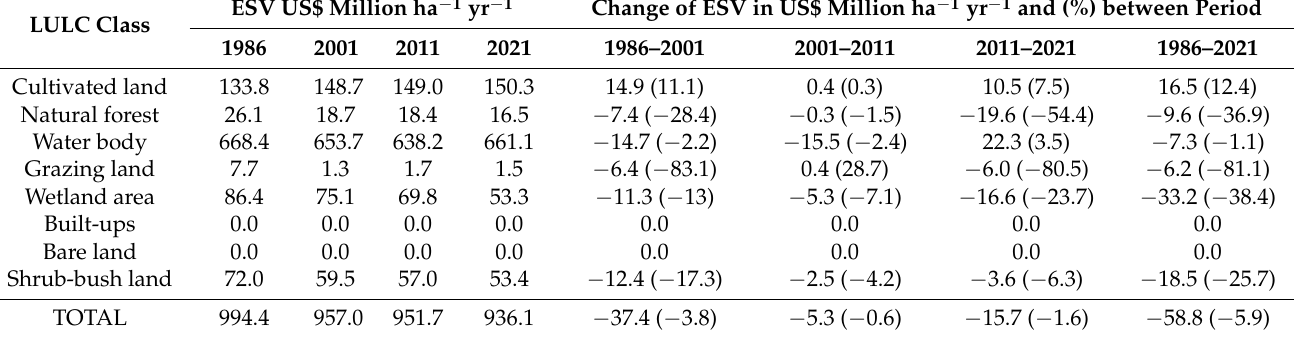
Table 5. ESV (US $ million ha − 1 yr − 1 ) of each LULC class and its change over study periods (1986 to 2021). Figures in parentheses indicate a change of ESV in percent